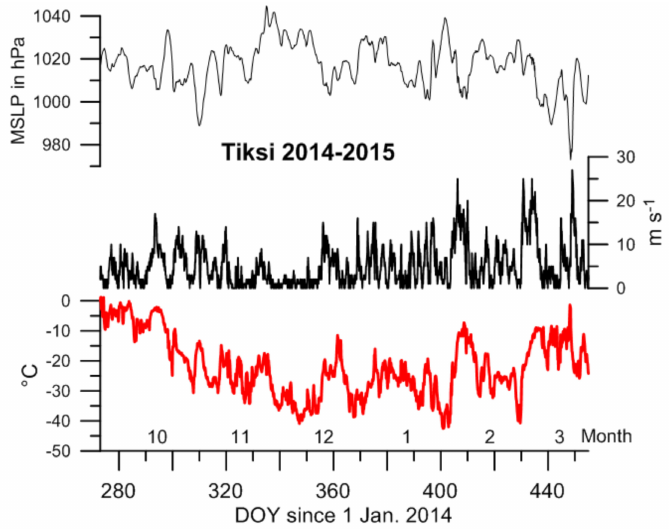
Figure 2. Time series of the 2 m-temperature (red line), 10 m-wind speed, and mean sea level pressure (MSLP) during the investigation